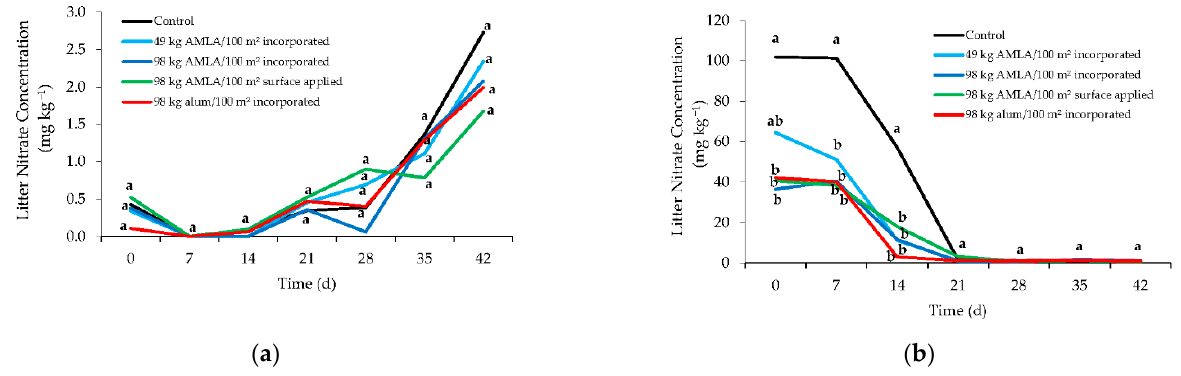
Figure 2. Average nitrate litter concentrations (mg NO 3 -N kg − 1 ) for ( a ) flock 2 and ( b ) flock 3 as a function of time. Treatments not sharing a common letter are significantly different ( p < 0.05).